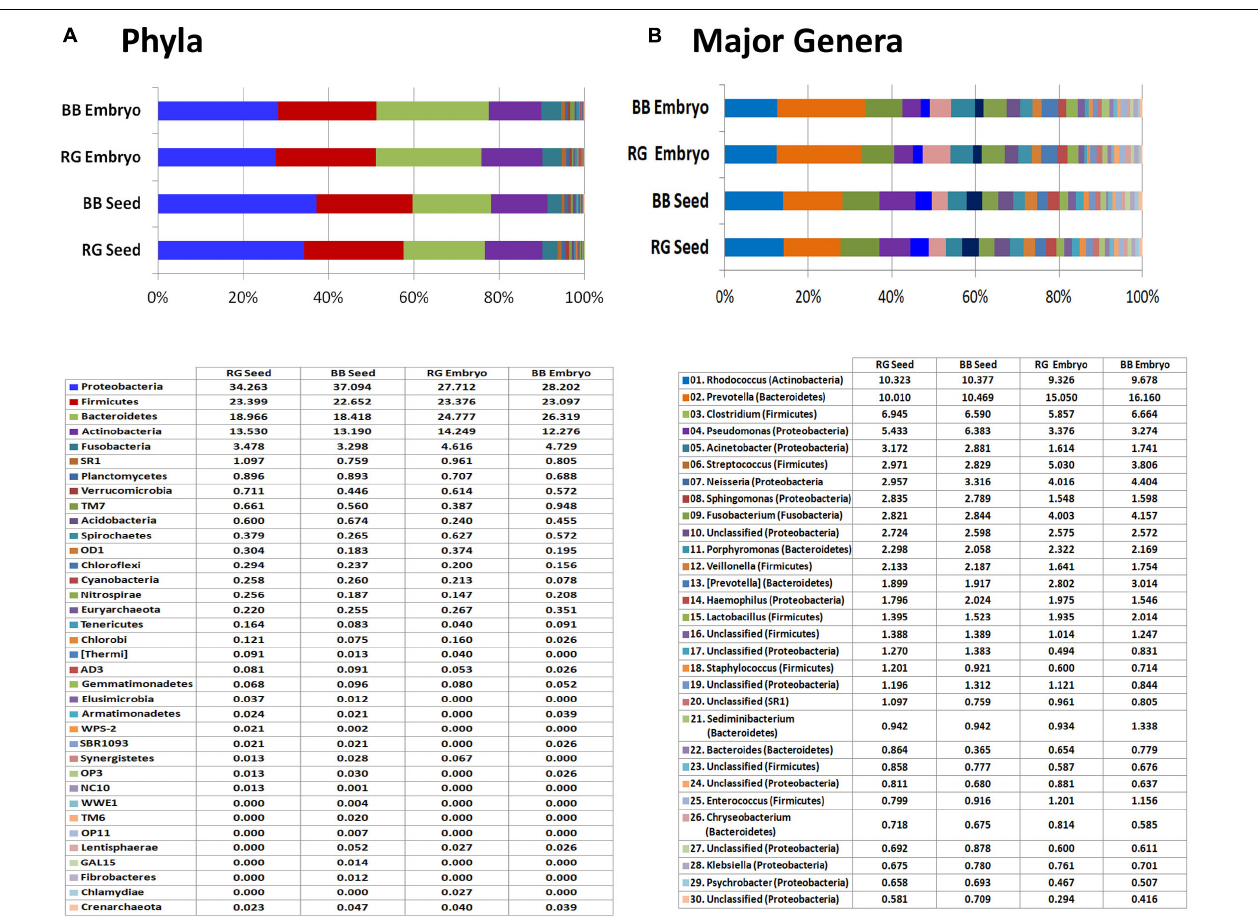
FIGURE 8 | 16S rRNA metagene V3–V4 region profiling with Illumina MiSeq NGS platform on grapevine seeds and embryos. (A) Distribution of OTUs (%) under different phyla. (B) Major genera (OTU %) in the four